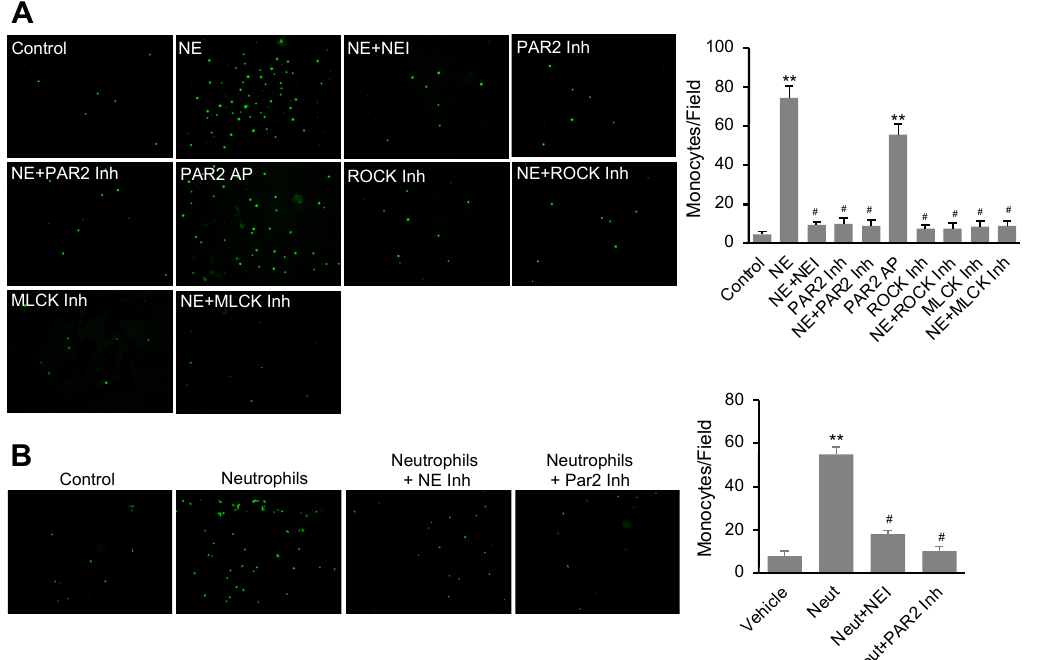
Figure 5. Interaction of endothelial cells with NE or isolated neutrophils stimulated monocyte transendothelial migration via activation of the PAR2 pathway. ( A ) Confluent hECs grown on collagen-coated transwell inserts (8 µ m pore size) were treated with NE (20 nM) or PAR2 agonist (PAR2-AP, 7.5 µ M) in the presence or absence of NE inhibitor (NEI, 1 µ M), PAR2 inhibitor (PAR2 Inh, 1 µ M), ROCK inhibitor (ROCK Inh, 5 µ M), and MLCK inhibitor (MLCK Inh, 5 µ M) for 16 h. hECs were washed with normal media before adding BCECF-AM labeled THP-1 cells (1 × 10 5 ) for 6 h. ( B ) Confluent hECs on transwell inserts were treated with freshly isolated neutrophils (1 × 10 6 cells/well) for 16 h in the presence or absence of NE inhibitor (NEI, 1 µ M) or PAR2 inhibitor (I191, 1 µ M). hEC monolayer on the top chamber was washed with cell media to remove neutrophils. Then, BCECF-AM labeled THP-1 cells (1 × 10 5 cells/well) were used to assess transmigration for 2 h. Representative images show fluorescence-labeled THP-1 cells transmigrated through the hEC mono- layer were captured ( A , B ). For quantification, monocytes were counted in five random microscopic fields per well. The values are expressed as mean ± SD of three independent experiments. Top panel: ** p < 0.01 vs. vehicle control group, # p < 0.05 vs. NE group; lower panel: ** p < 0.01 vs. vehicle control group, # p < 0.05 vs. neutrophil (Neut)